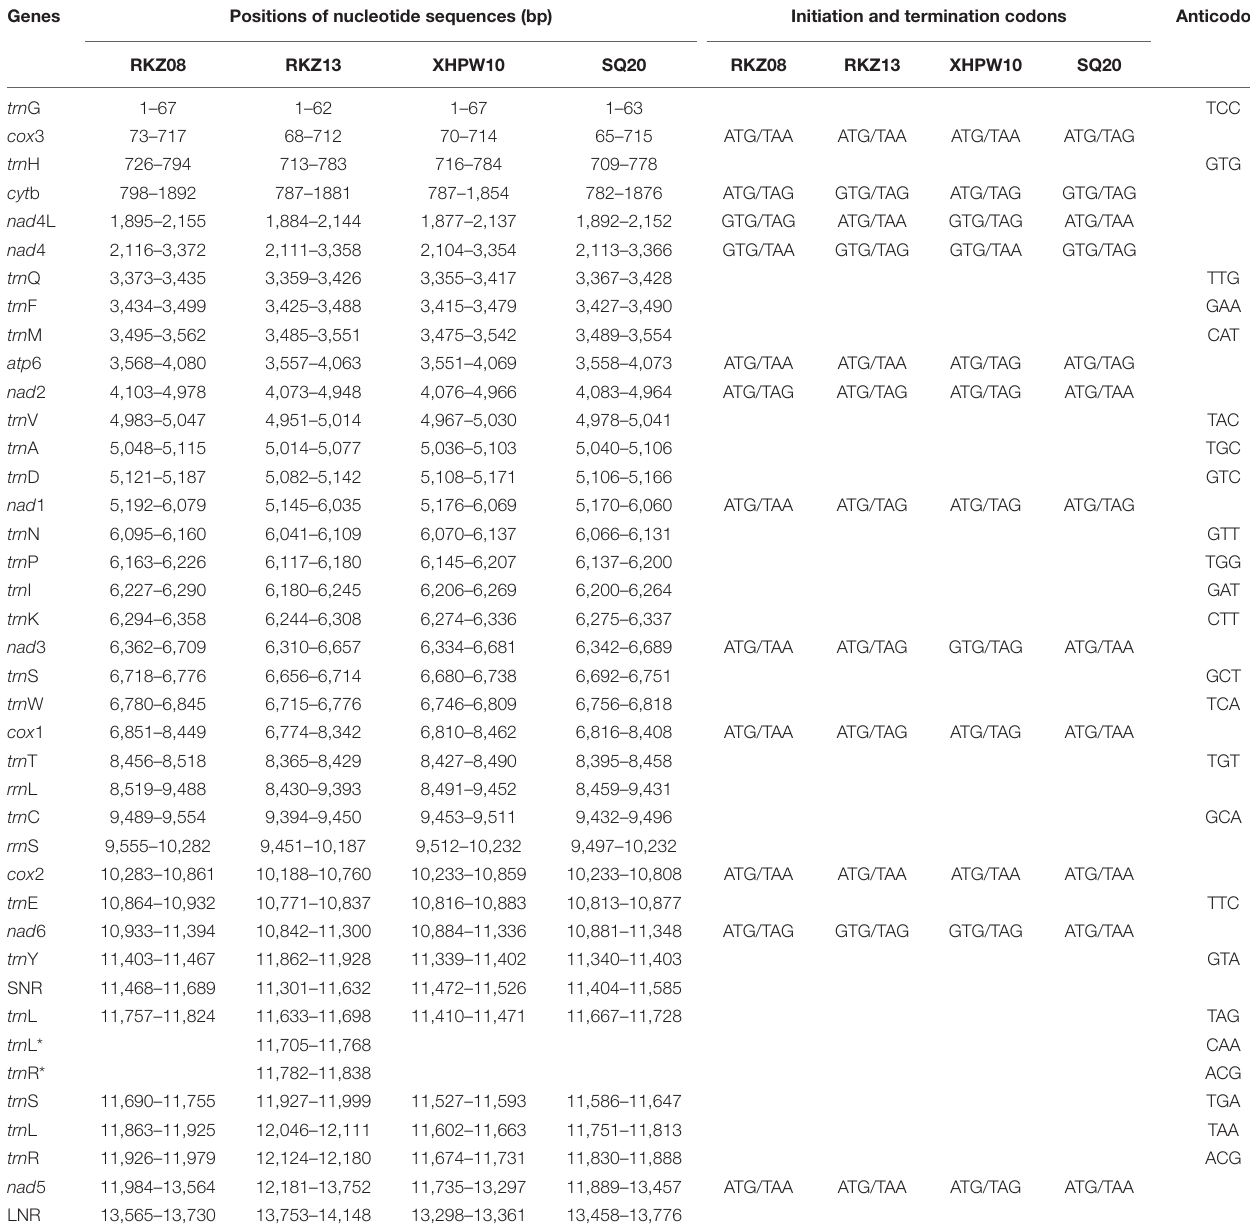
TABLE 1 | The list of mitochondrial genome annotation for four “putative new species”. Genes Positions of nucleotide sequences